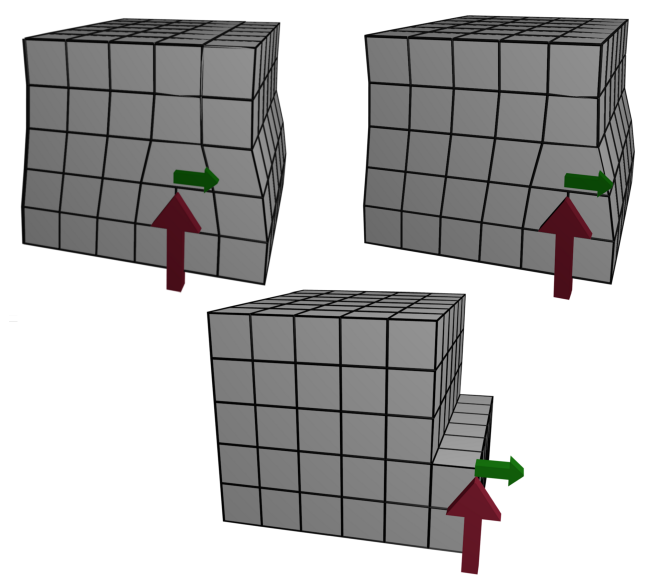
Figure 6: Glide motion of an edge dislocation under static shear stress. The disloca- tion will move in the direction of its Burgers